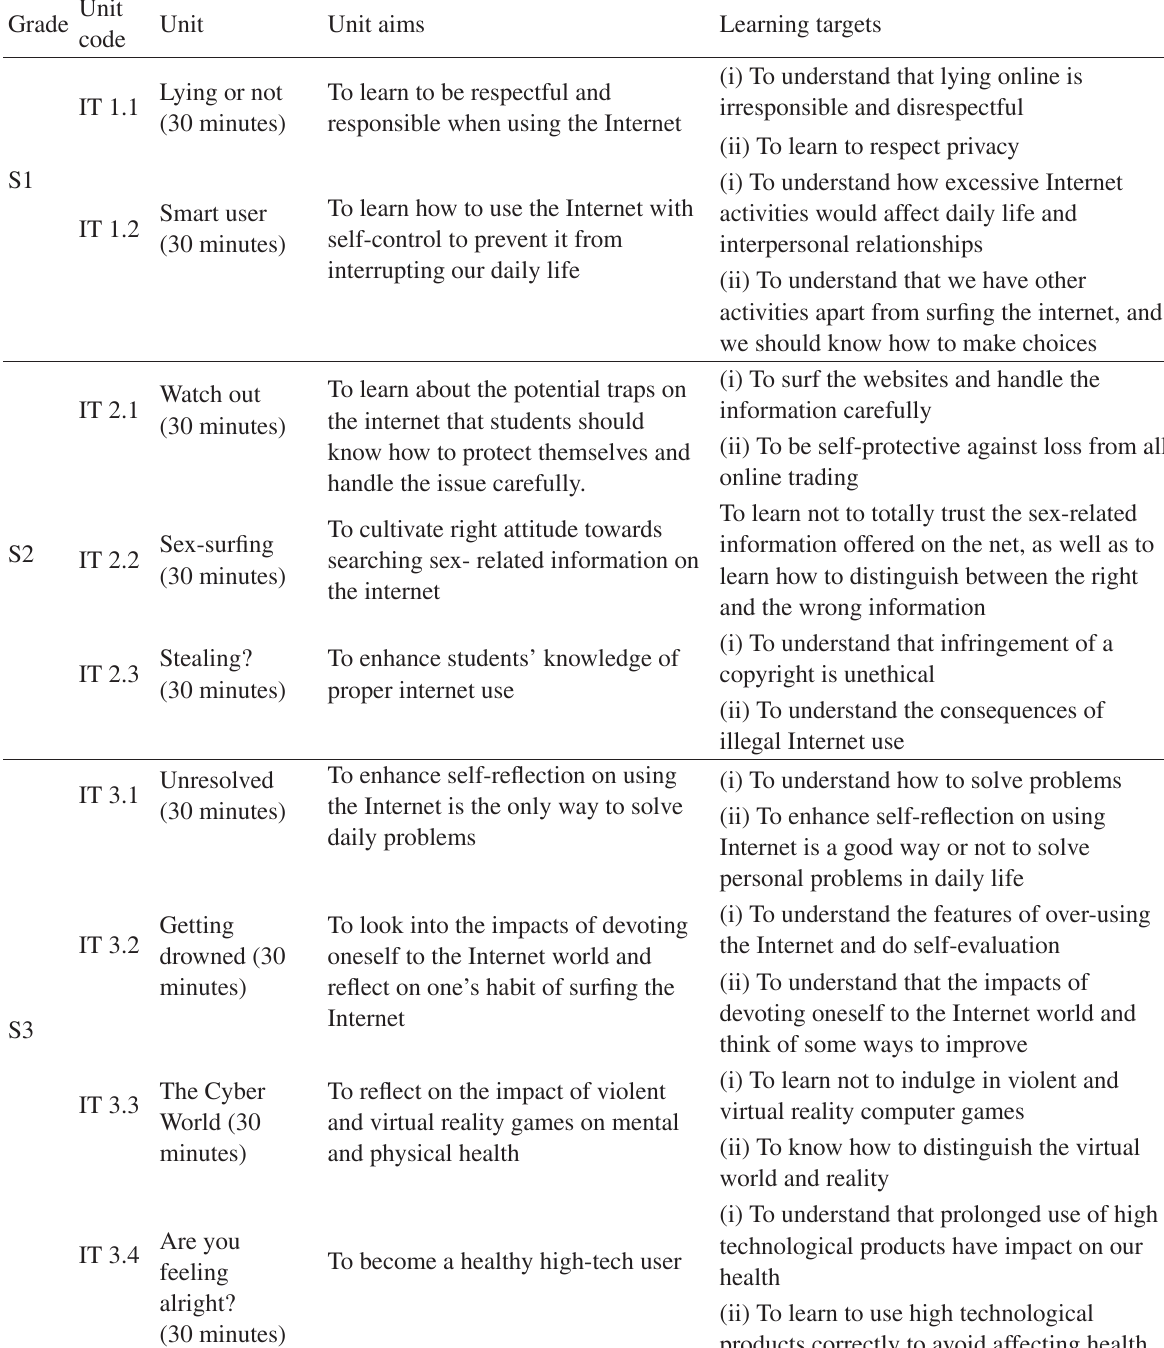
TABLE 1: P.A.T.H.S. program: Internet use teaching kit